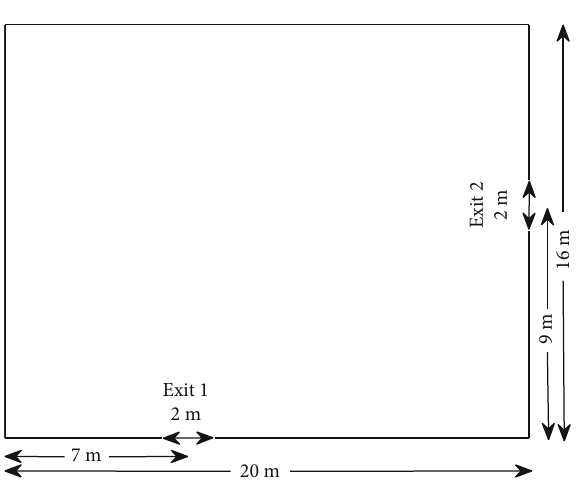
Figure 1: Modeling area for the numerical